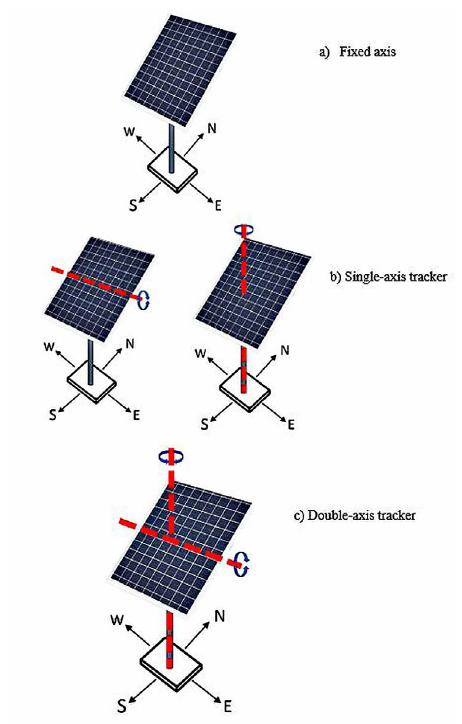
Fig. 1. Different tracking types for PV Power Plant (authors’ elaboration).